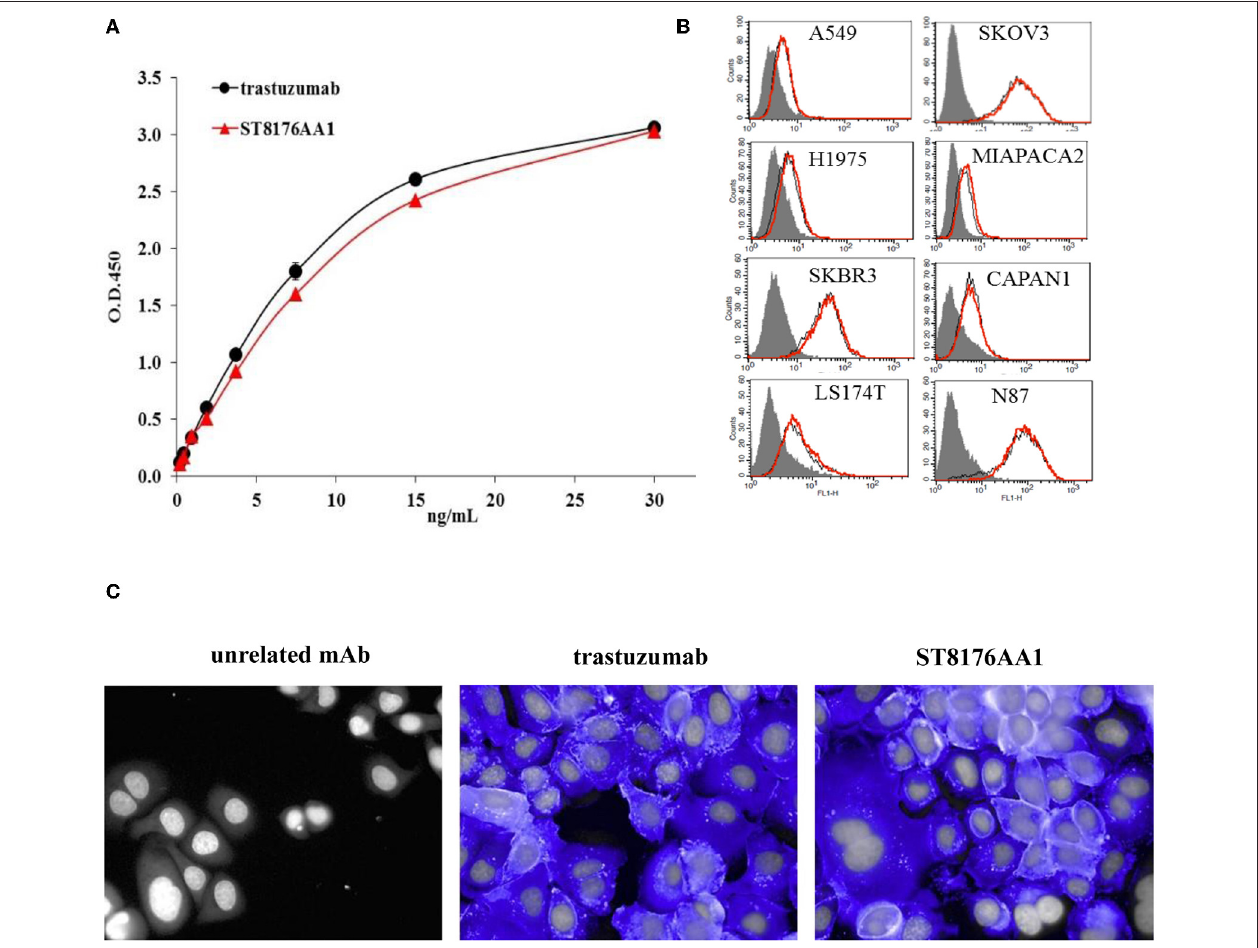
FIGURE 2 | Receptor binding and cellular internalization of ST8176AA1. (A) Immunoreactivity of ST8176AA1 compared to trastuzumab by ErbB2-specific ELISA. Results are the mean of two independent experiments ± SD. (B) Binding of ST8176AA1 (red line) compared to trastuzumab (black line) by cytofluorimetry to human lung (NCI-H1975 and A549), breast (SKBR3), pancreas (Capan-1 and MiaPaCa2), ovary (SKOV3), colon (LS174T), and gastric (N87) carcinoma cell lines. Cell pellets were incubated with test items and then stained with FITC-conjugated mouse anti-human Ig and propidium iodide. Gray peaks refer to cells without primary antibody. (C) Internalization of ST8176AA1 and trastuzumab (both at 5 µ g/mL) by SKBR3 breast cancer cells, as measured by HCS fluorescence imaging after 1h incubation. After washing, the cells were fixed and stained by using FITC-conjugated mouse anti-human Ig (blue signal). Draq5 dye staining of nucleus (gray). Each image is representative of at least five fields of duplicate wells. Magnification 60X. Data are from one representative experiment out of